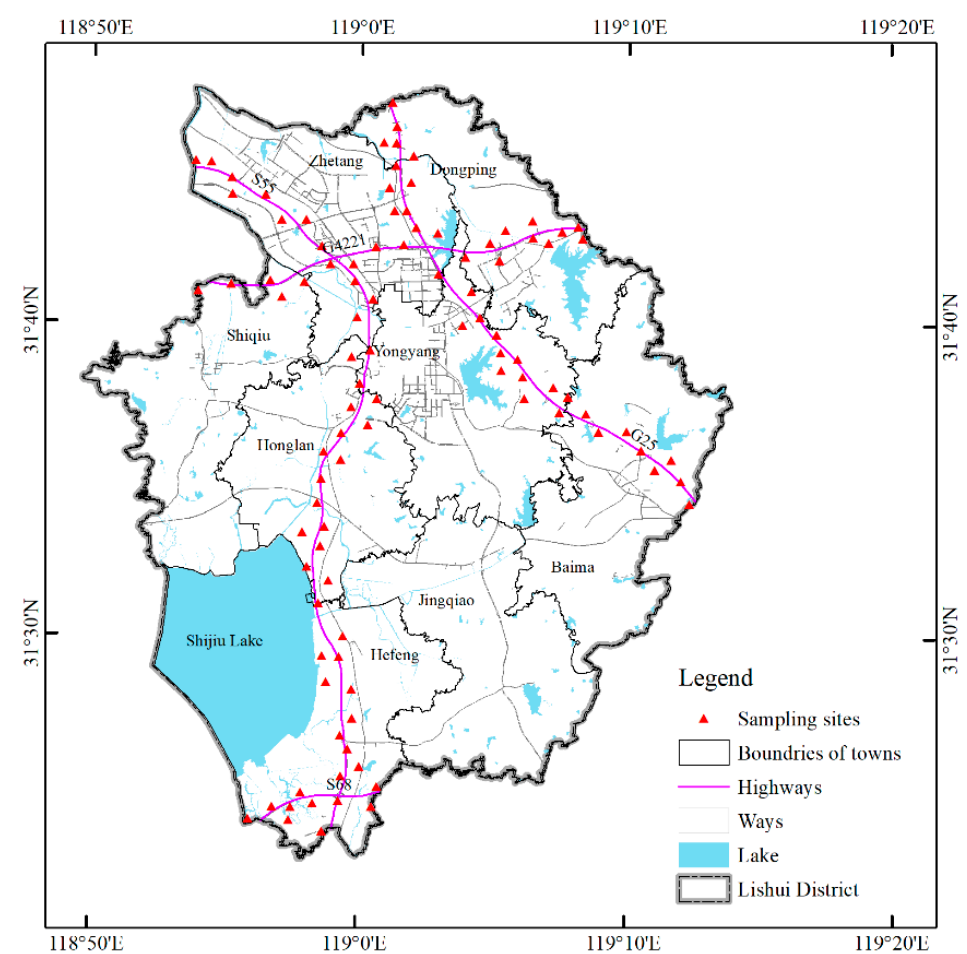
Figure 1. The study area and the distribution of the sampling sites.